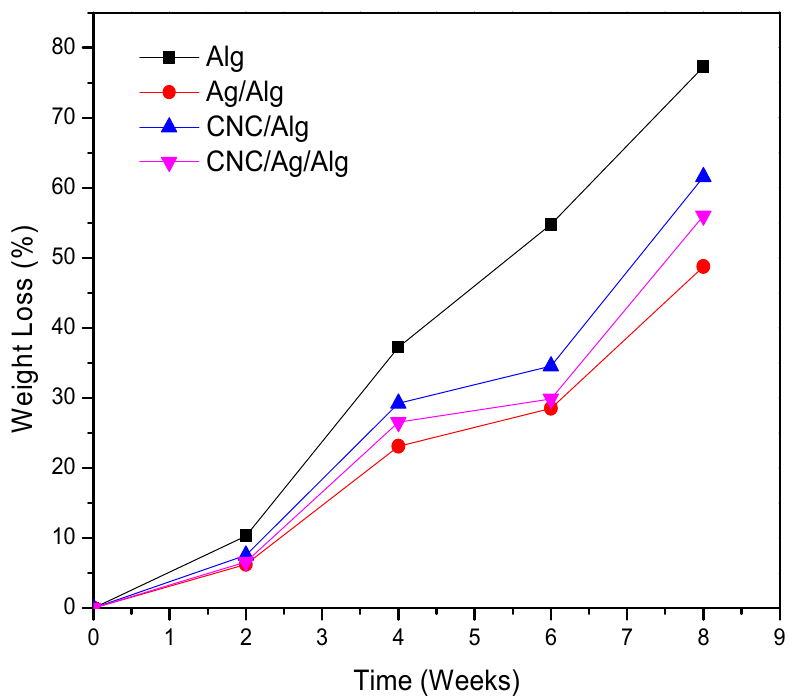
Figure 8. Biodegradation curves for Alg, Ag / Alg, CNC / Alg, and CNC / Ag / Alg films.